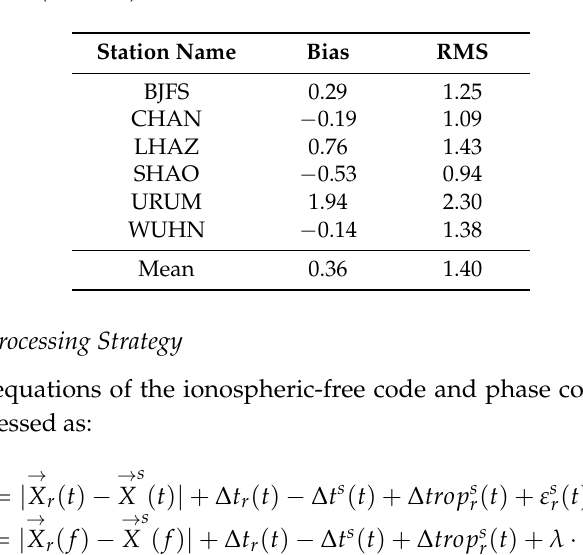
Table 1. The bias and RMS of differences between IGS final ZTD products and ZTD derived from reanalysis for year 2014 (unit: